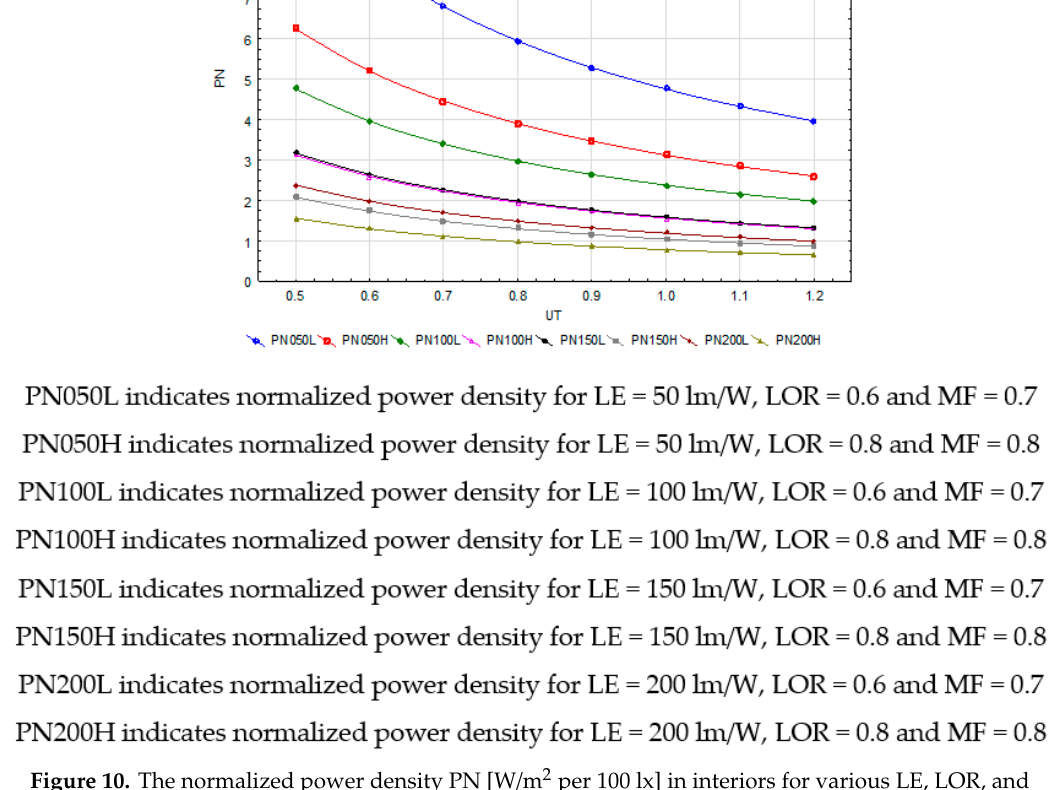
Figure 10. The normalized power density PN [W / m 2 per 100 lx] in interiors for various LE, LOR, and MF levels. Table 9. The energy e ffi ciency classification proposal for interior lighting based on the normalized power density PN [W / m 2 per 100